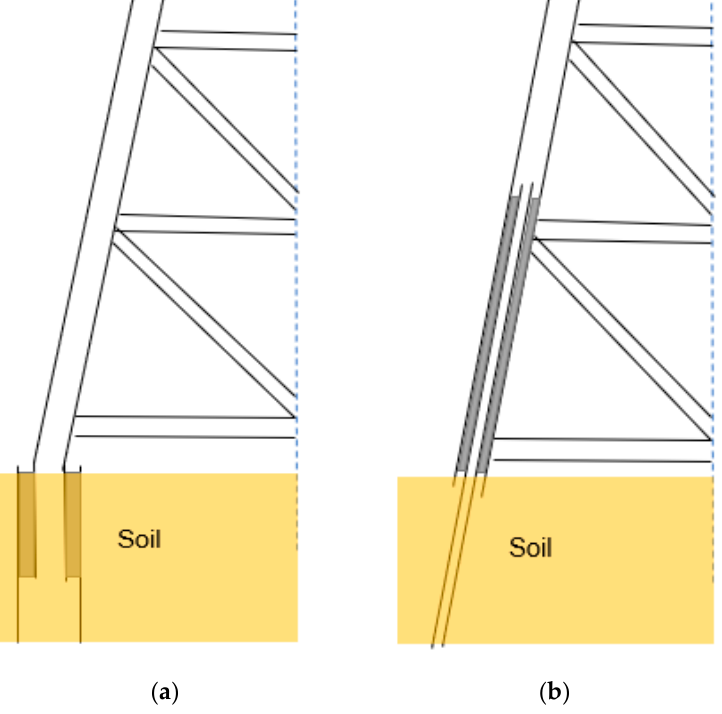
Figure 20. Types of grouted connections. ( a ) Pile in leg. ( b ) Leg in pile.